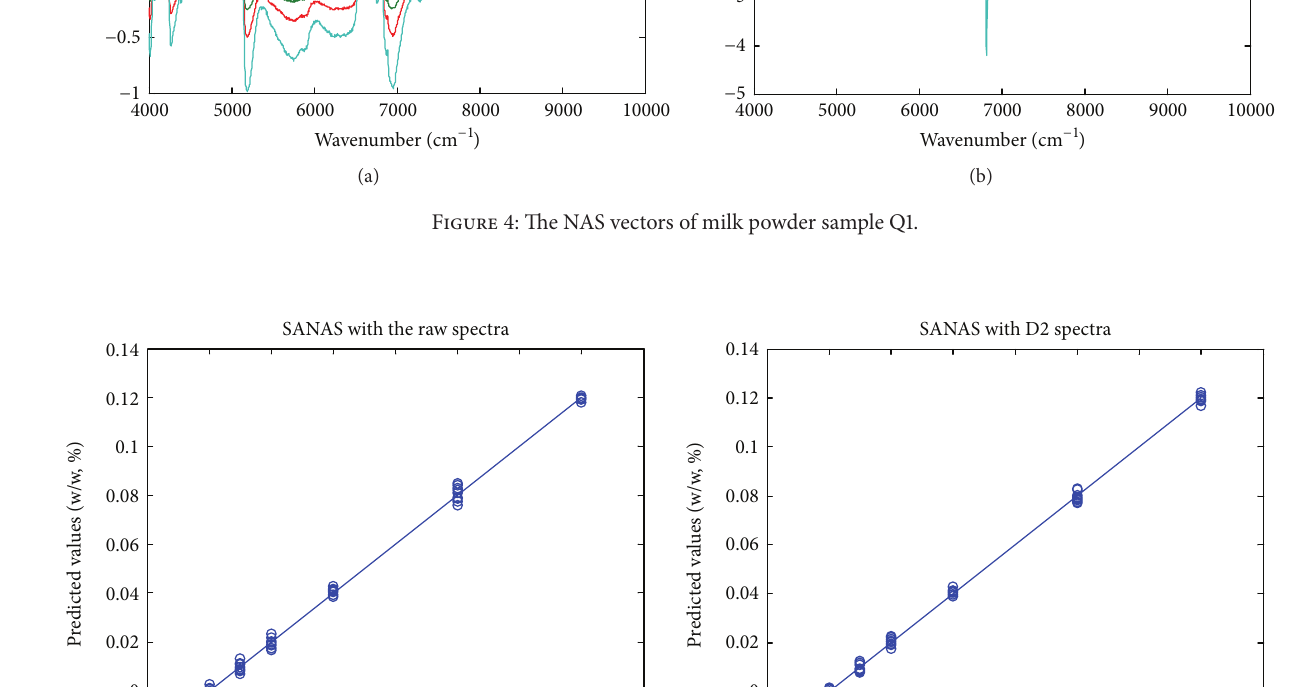
Figure 5: The prediction results and reference values of melamine levels by